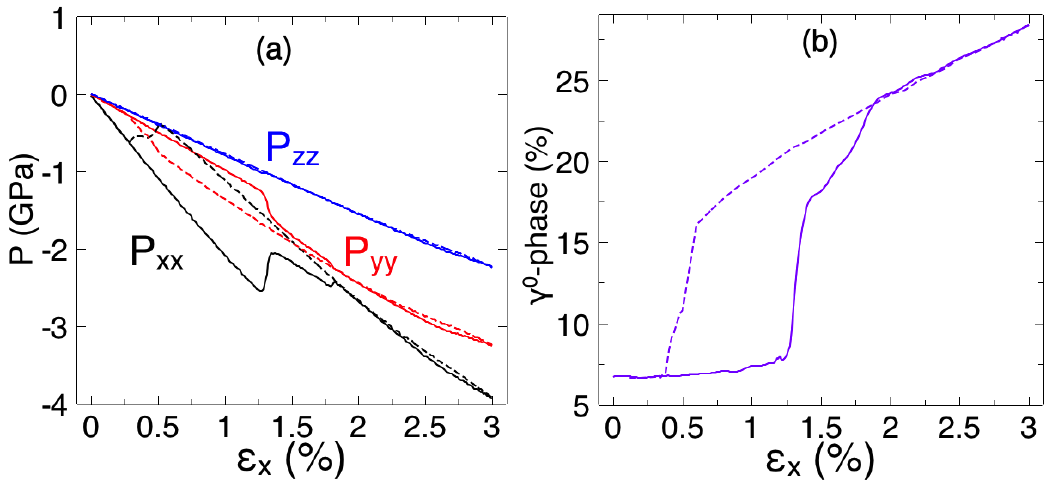
Figure 4. ( a ) Calculation results for uniaxial deformation of U–10 at.% Mo alloy at room temperature. Extension takes place along the x direction. The dependencies of pressure components on deformation: solid lines—initial extension; dashed lines—inverse deformation to initial sizes of the calculation cell. ( b ) γ 0 -phase fraction in % during